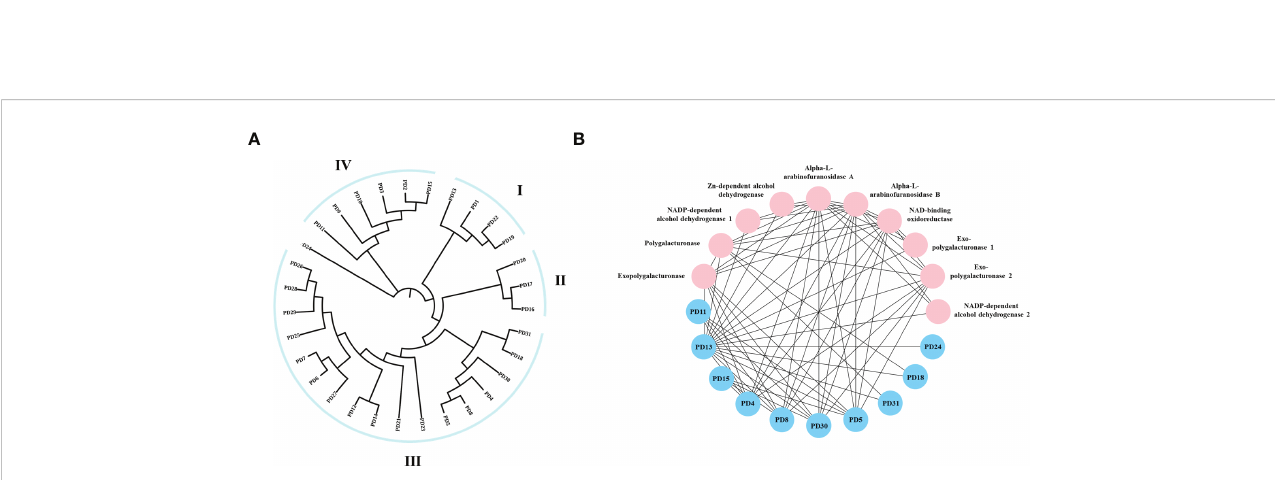
FIGURE 7 Phylogenetic tree and interaction network of pectin degrading enzymes genes. (A) The phylogenetic tree was generated from PD amino sequences using RAxML software by the Maximum Likelihood method with 500 bootstrap replicates. (B) Nodes represent proteins, and edges indicate protein- protein interaction. Edges colors indicate the type of evidence for interaction. Asterisk (*) represents signi fi cant difference (P < 0.05).